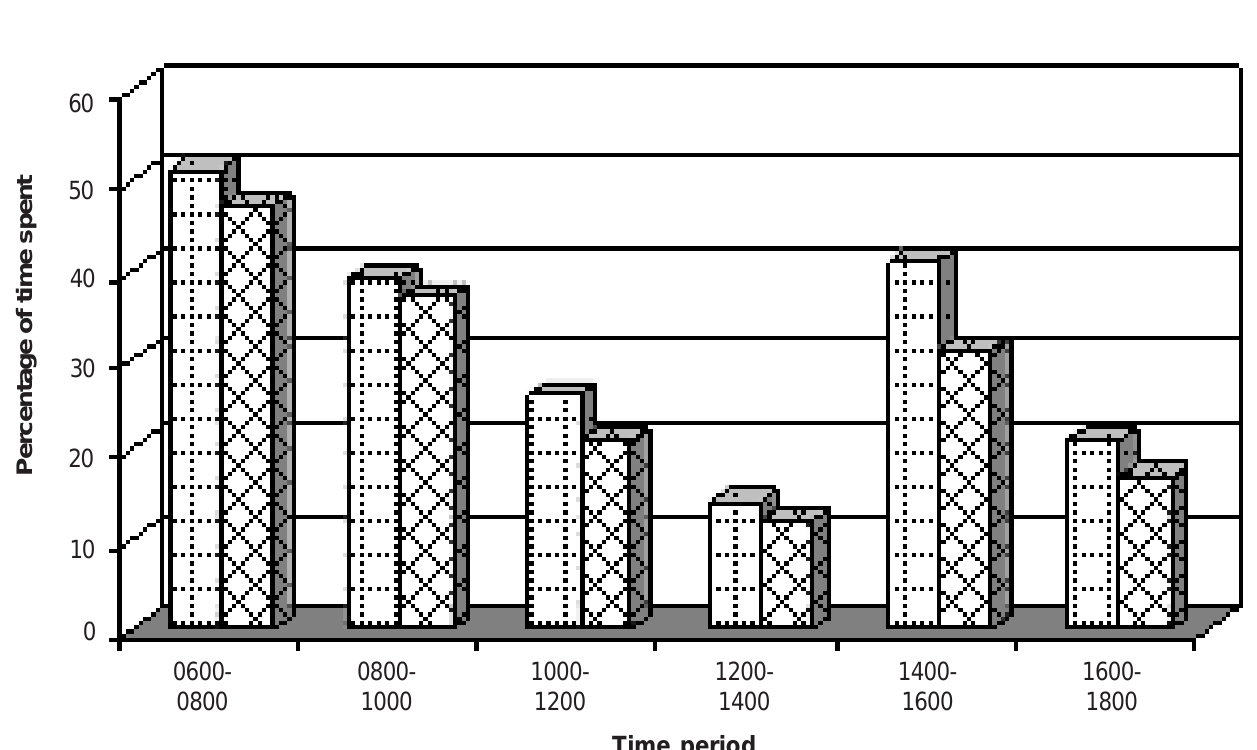
Figure 3. Diurnal variation of feeding and foraging of Trachypithecus